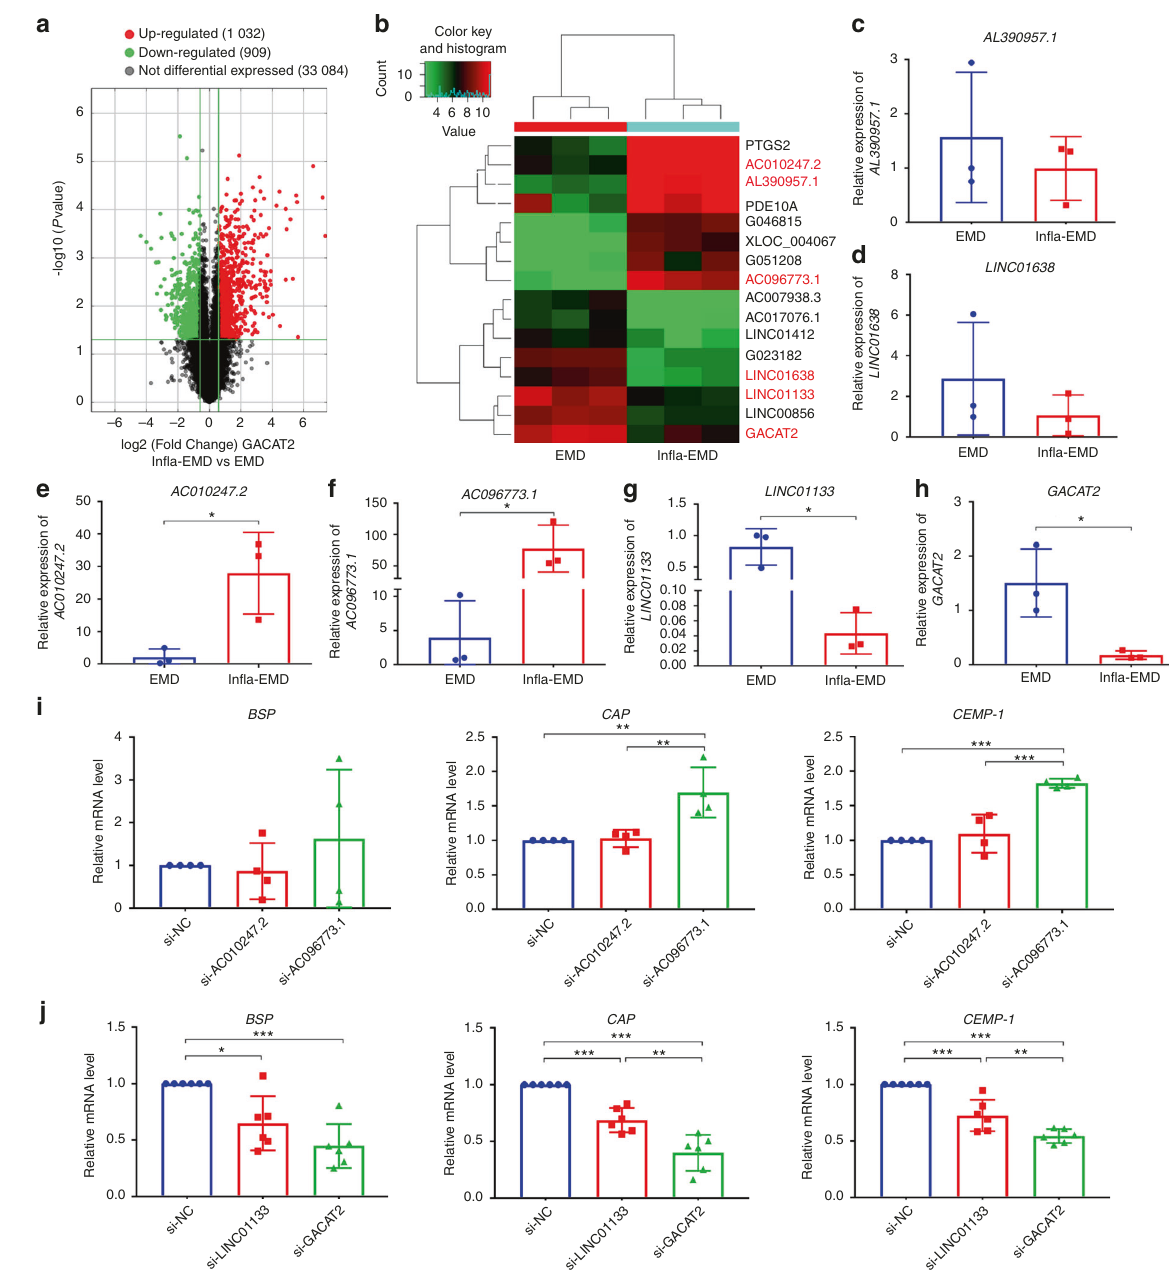
Fig. 4 Identi fi cation and validation of GACAT2 as a key lncRNA associated with the cementoblastic differentiation of PDLSCs. a – h Identi fi cation of differentially expressed lncRNAs between the PDLSCs incubated in nonin fl ammatory environments and the PDLSCs incubated in in fl ammatory environments. The cells were incubated in medium with the cementoblastic inducer EMD alone (EMD) or EMD plus in fl ammatory cytokines (In fl a-EMD). a Volcano plots of the differentially expressed (fold change >1.5 and adjusted P < 0.05) lncRNAs in the PDLSCs between the EMD and In fl a-EMD groups. b Heatmap of the top 8 lncRNAs with upregulated expression and the top 8 lncRNAs with downregulated expression in the PDLSCs of the EMD group compared with those in the In fl a-EMD group. Six lncRNAs, AL390957.1 ( c ), LINC01638 ( d ), AC010247.2 ( e ), AC096773.1 ( f ), LINC01133 ( g ), and GACAT2 ( h ), were selected for qRT-PCR veri fi cation according to their RNA length (<2 000 nt), intensity (>100), relation (without overlapping with coding transcripts) and database source (in the GENCODE or RefSeq public databases), and 10 other lncRNAs were excluded. c and d No signi fi cant changes in AL390957.1 and LINC01638 expression were observed in the cells incubated in the nonin fl ammatory or in fl ammatory environments. e and f AC010247.2 and AC096773.1 expression was signi fi cantly increased in an in fl ammatory environment. g and h LINC01133 and GACAT2 expression was signi fi cantly decreased in an in fl ammatory environment. i The inhibition of AC096773.1 (si- AC096773.1 ), but not AC010247.2 (si- AC010247.2 ), increased the relative cementoblastic differentiation-related gene expression levels of BSP , CAP and CEMP-1 in the PDLSCs incubated in an in fl ammatory environment (qRT-PCR). j The inhibition of LINC01133 (si- LINC01133 ) or GACAT2 (si- GACAT2 ) decreased the relative cementoblastic differentiation-related gene expression levels of BSP , CAP and CEMP-1 in the PDLSCs incubated in a nonin fl ammatory environment (qRT-PCR); the most signi fi cant change was observed in response to GACAT2 inhibition. The data are shown as the mean ± SD for n from 3 to 6; * P < 0.05, ** P < 0.01 and *** P < 0.001 indicate signi fi cant differences between the indicated